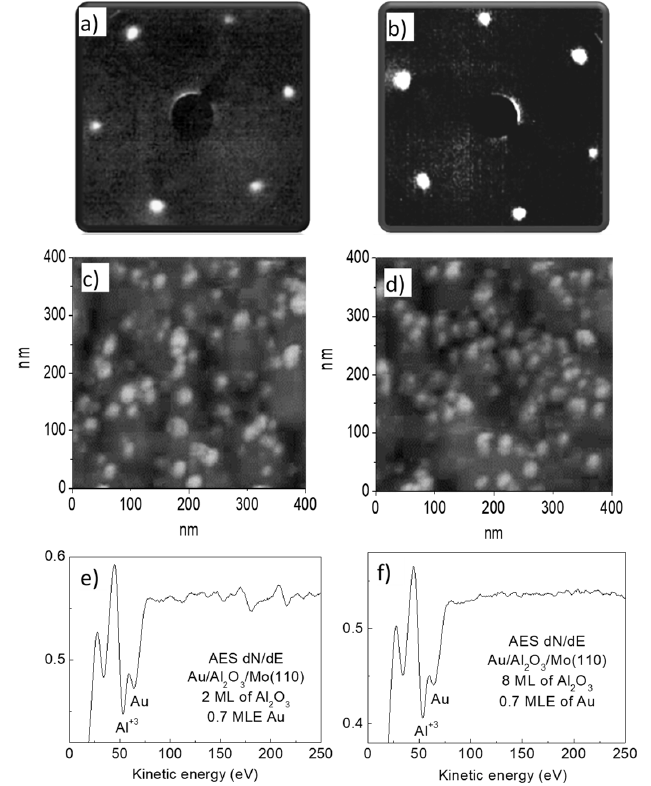
Figure 1. LEED patterns of alumina 2 mL ( a ) and 8 M ( b ) thick films on Mo(110) substrate. AFM images of Au overlayers at a coverage 0.7 MLE on alumina 2 mL ( c ) and 8 M ( d ) thick films. Gold was deposited onto alumina held at room temperature and then annealed to 500 K for 3 min. Auger spectra corresponding to AFM images: ( e ) → ( c ), ( f ) → ( d ).